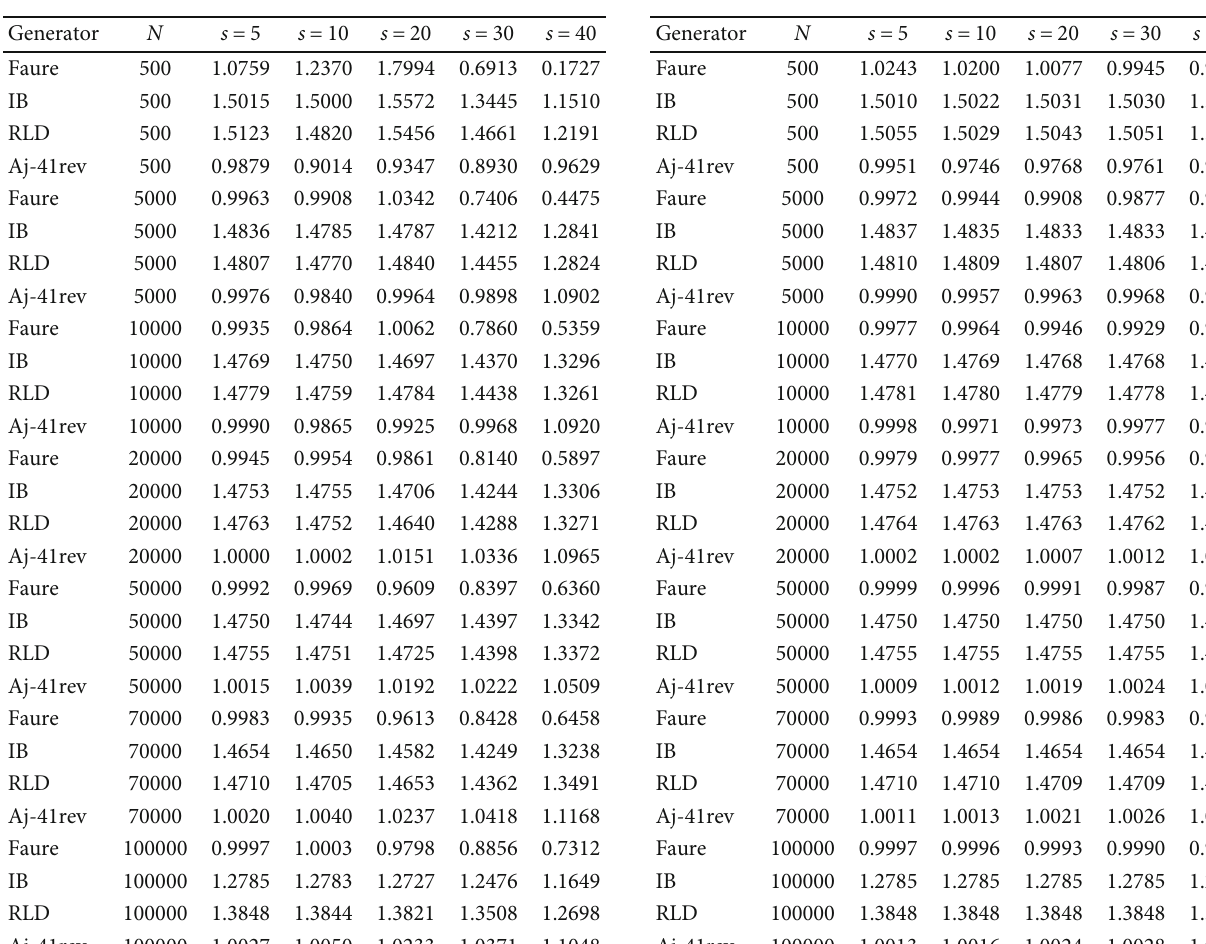
Table 3: Estimates of I